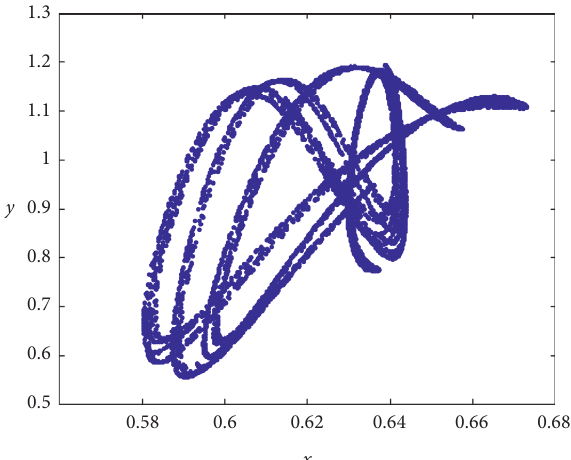
Figure 28: x - y phase diagram which denotes that the system is chaotic when c � 0.8.